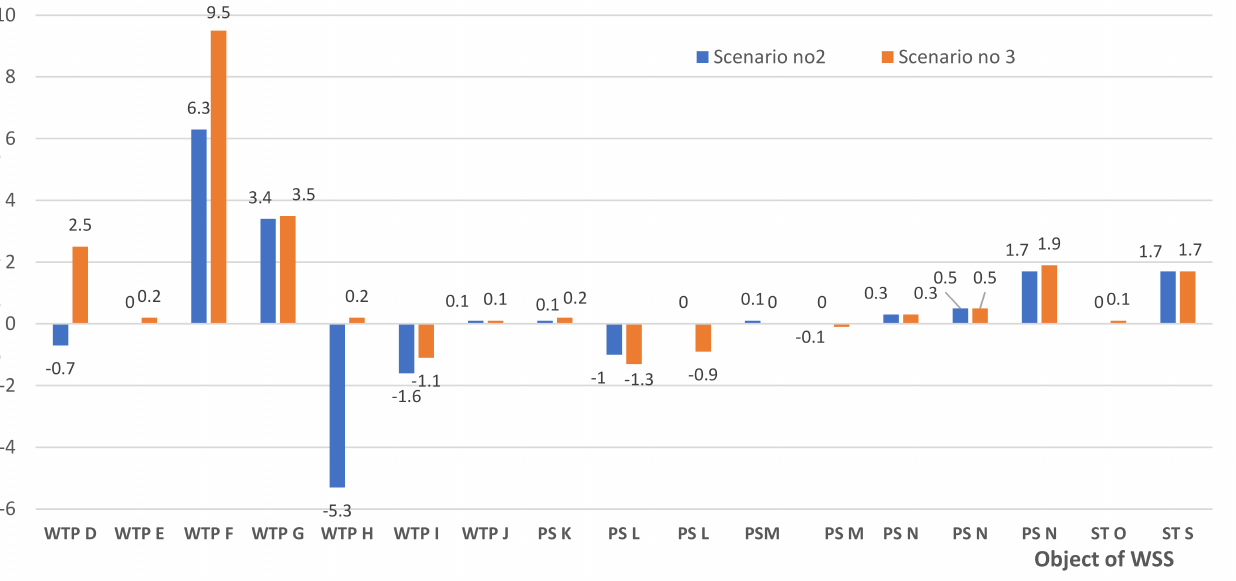
Figure 8. Change in pump efficiency in the analyzed pumps vs. Scenario no. 1 (WTP—water treatment plant, PS—pumping station, ST—storage